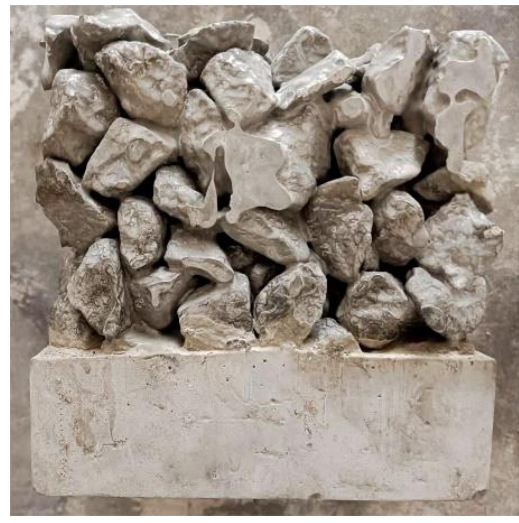
Figure 5. Planting Figure 5. Planting experiment.